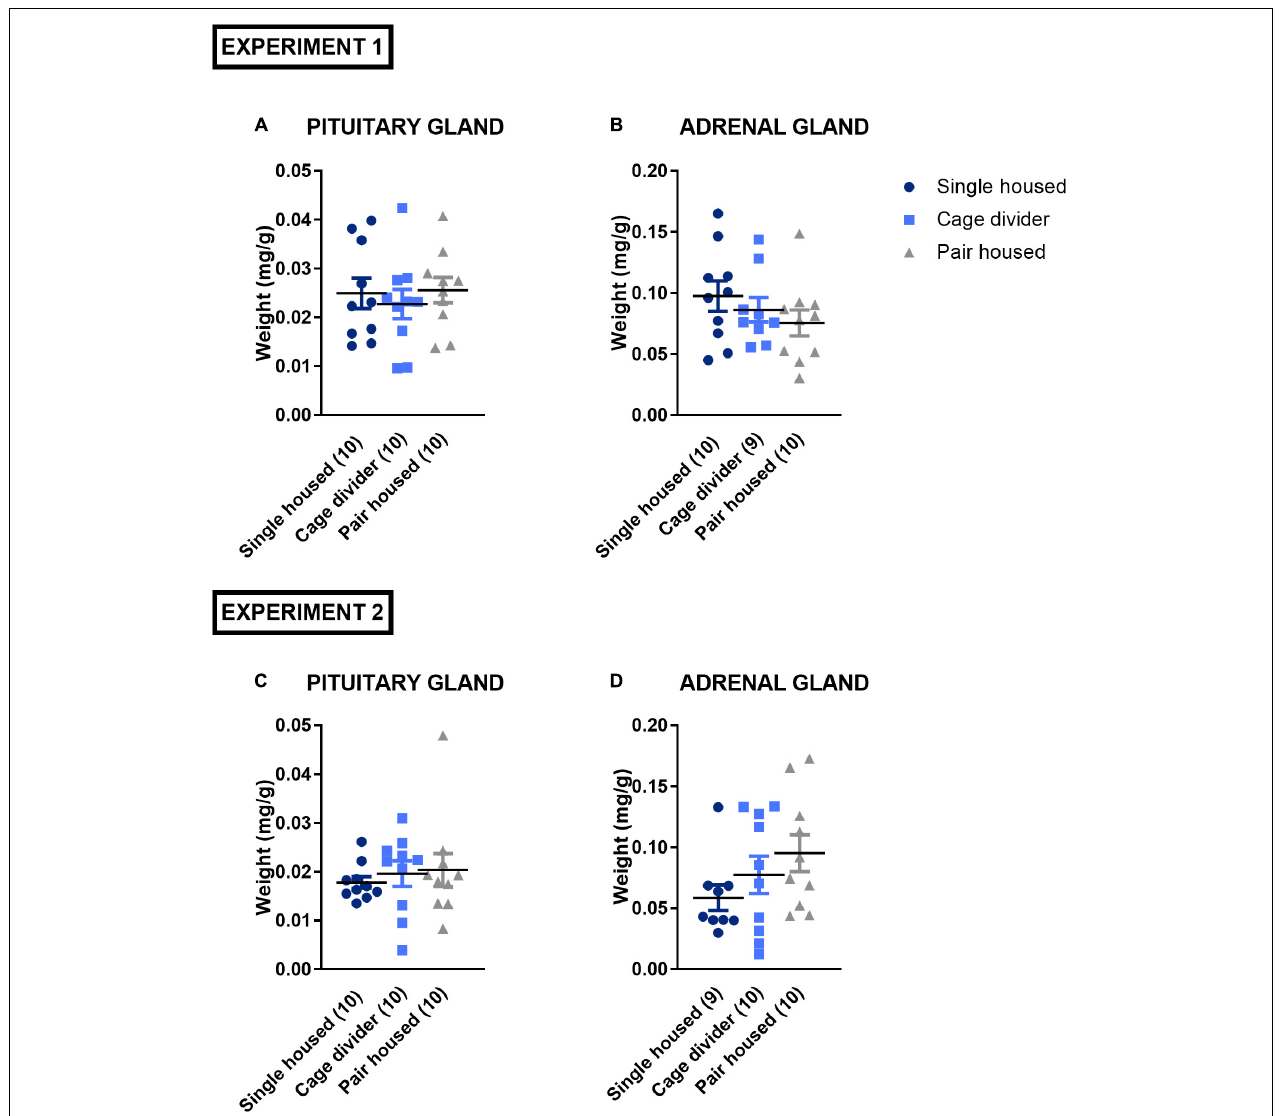
FIGURE 6 | Weights of pituitary and adrenal glands normalized to body weight from mice that were single housed, pair housed and pair housed with a cage divider. (A) Normalized pituitary gland weight of experiment 1. (B) Normalized adrenal gland weight of experiment 1. (C) Normalized pituitary gland weight of experiment 2. (D) Normalized adrenal gland weight of experiment 2. Data are presented as mean ± SEM. n = 9–10 mice/housing condition. Statistical analysis: Ordinary One-way